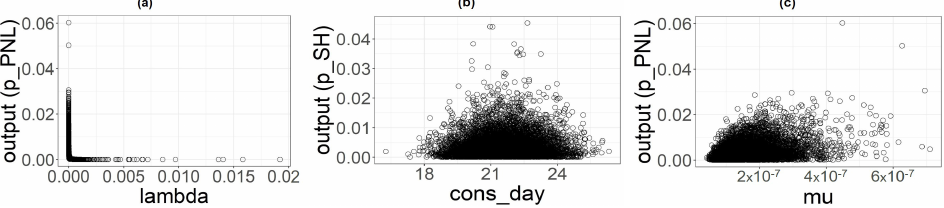
Figure 8. Scatterplot of input parameters for category SH versus the output considered ( p SH ). ( a ) λ SH . ( b ) cons SH ( c ) µ . day